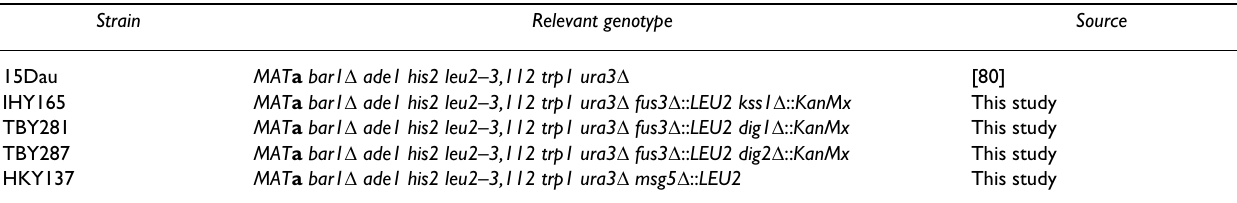
Table 2: S. cerevisiae strains used in this study Strain Relevant